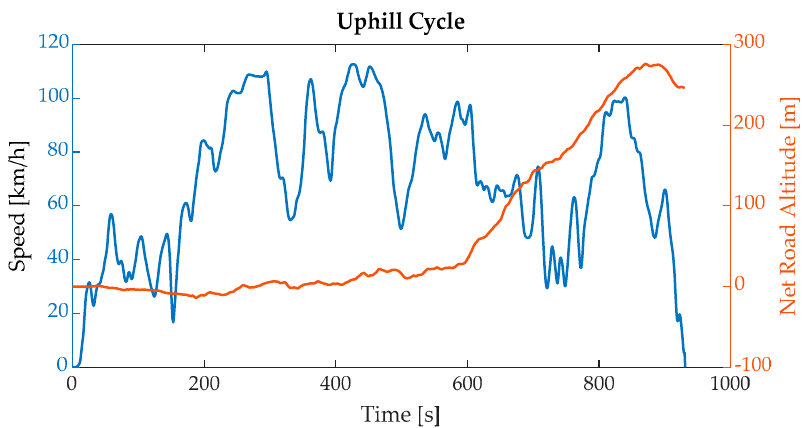
Figure 3. Speed profile of the urban real ‐ world drive mission.